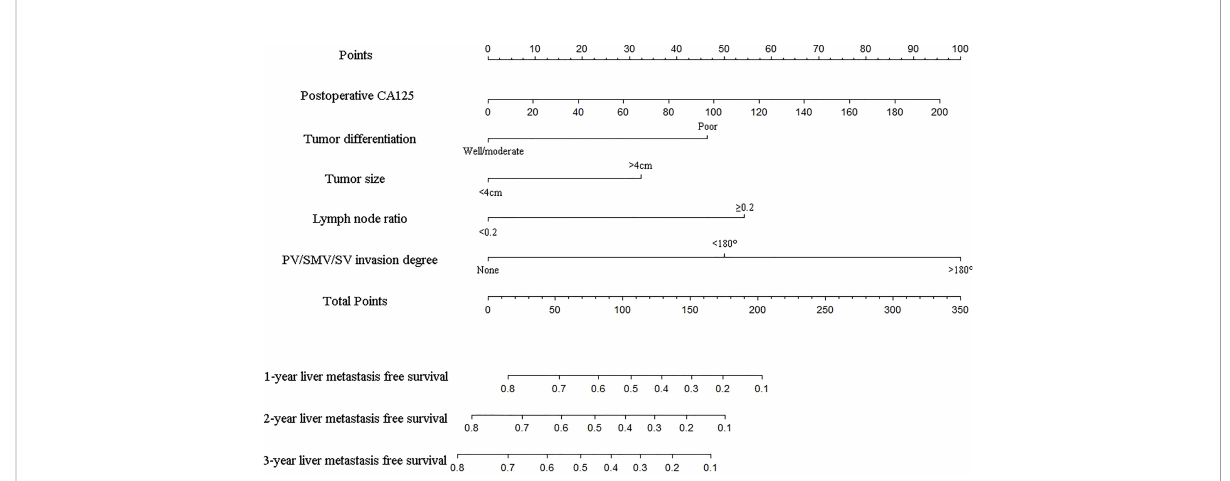
FIGURE 2 Nomogram for predicting the 1-, 2- and 3-year liver metastasis-free survival in PDAC patients after the operation. The nomogram was established in the training group, with postoperative CA125, tumor differentiation, tumor size, lymph node ratio and PV/SMV/SV invasion